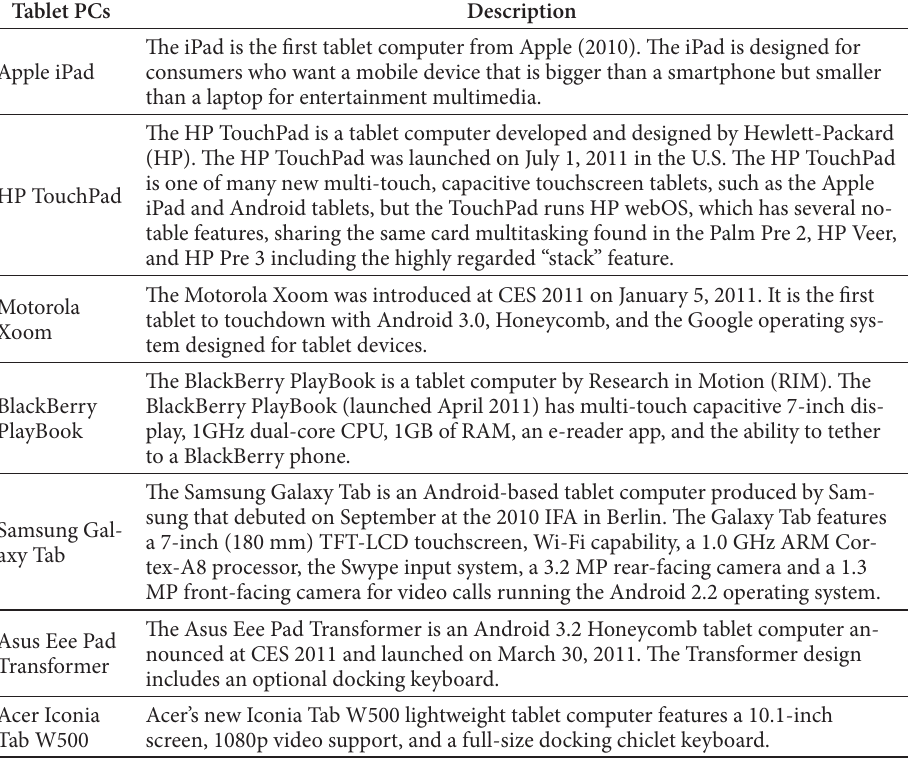
Table A2. Brief description of seven alternatives among tablet PCs Tablet PCs Description